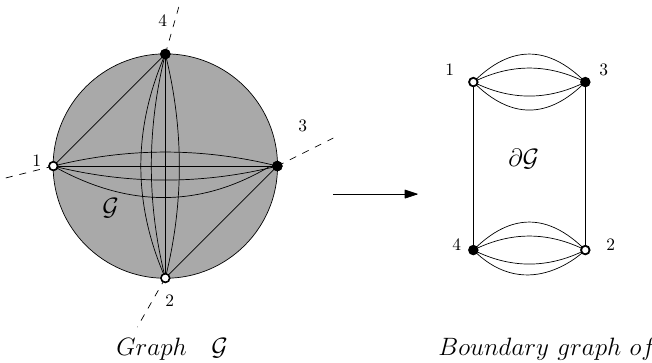
Figure 5. An opening Feynman graph with four external edges and its boundary graph. The strand in the interior of G represents the path following the external